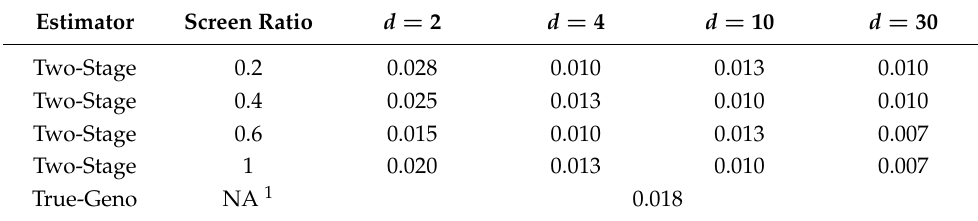
Table 3. Type 1 Errors with Multiple Test Adjustments for Binary Phenotype with Average Sequencing Depth d = 2,4,10,30 for Two-Stage Estimator and True Genotype-Based Estimator.